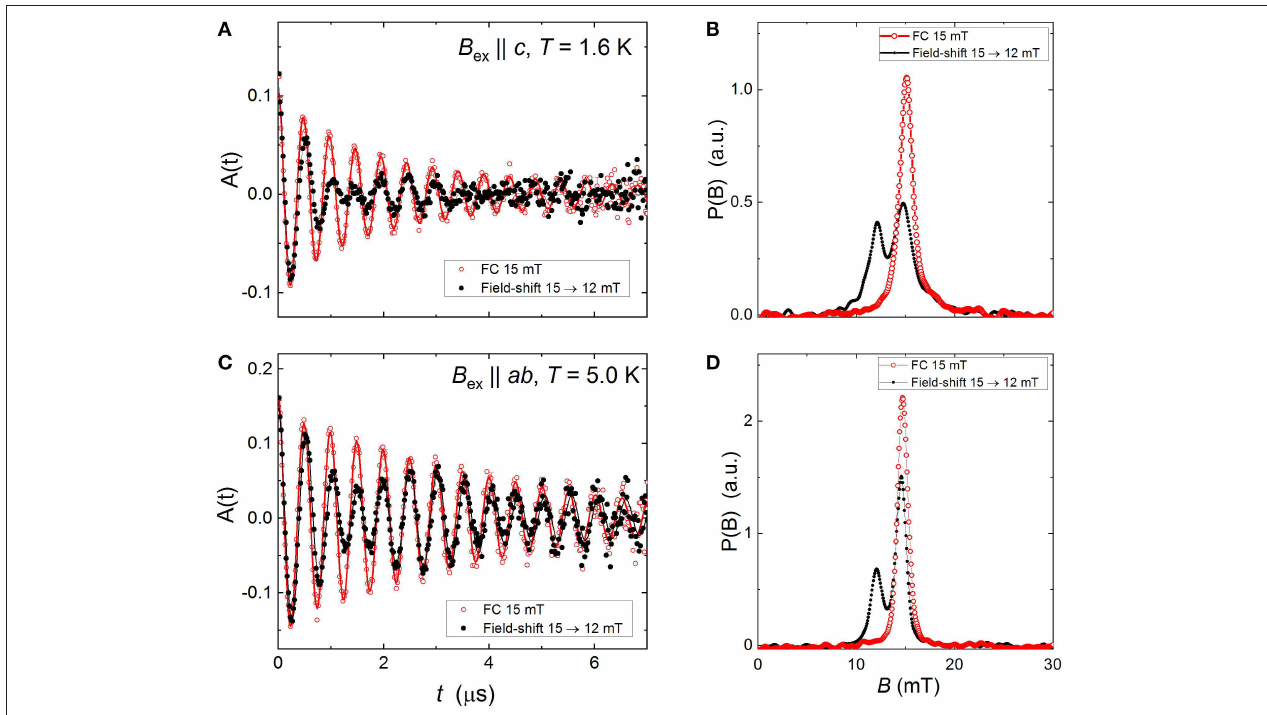
FIGURE 3 | (A) TF- µ SR time-spectra of NdFeAsO 0.65 F 0.35 measured at T TF- µ SR time-spectra denoted by red points correspond to the direct cooling at B ex time-spectra obtained after a subsequent field decrease to 12 mT without changing temperature. (B) The Fast Fourier transform of the TF- µ SR time-spectra presented at (A) . (C,D) —the same as in (A,B) , but for B ex